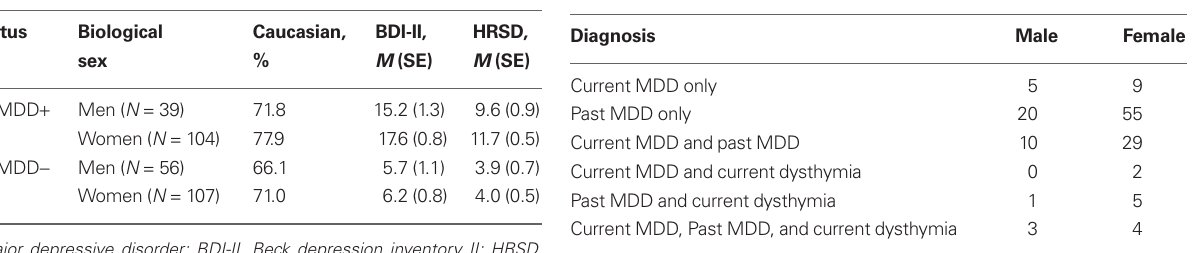
Table 2 | DSM-IV diagnoses endorsed in lifetime MDD + group ( N =